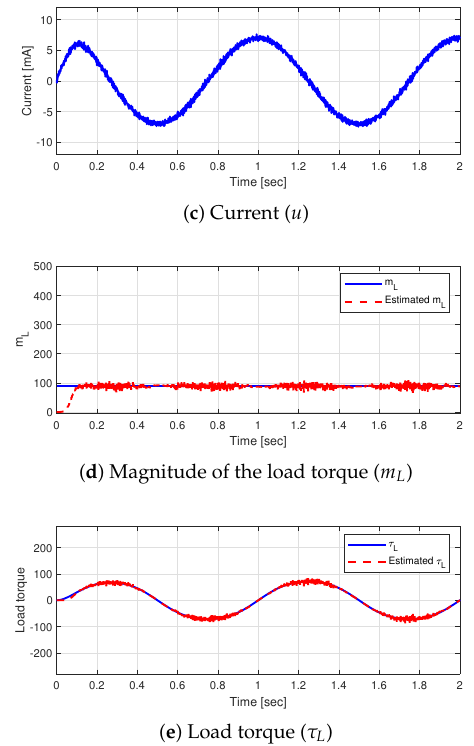
Figure 4. Simulation results for Case 1: position tracking performance ( x 1 and x d error ( e 1 ) ( b ), current ( u ) ( c ), magnitude of the load torque ( m L ) ( d ) and Load torque ( τ L ) ( e